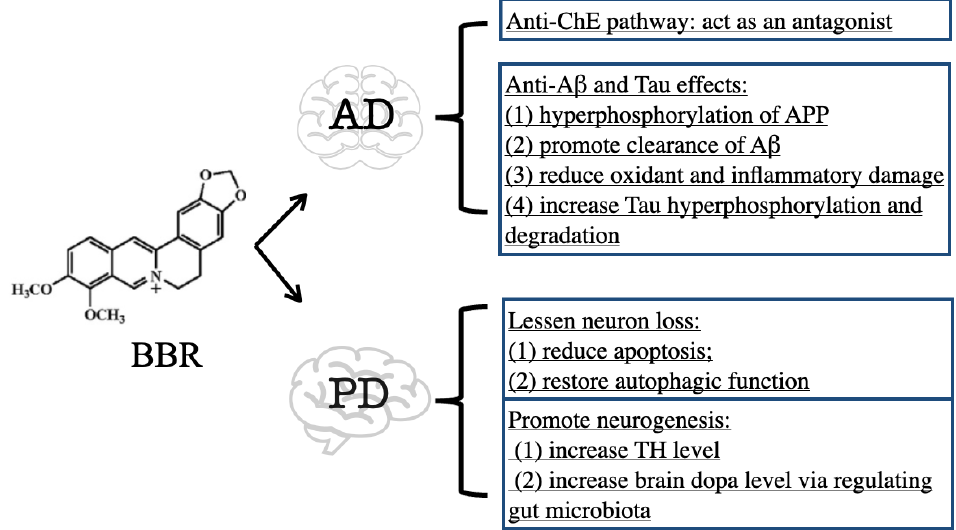
Figure 2. Effects of BBR against AD and PD.